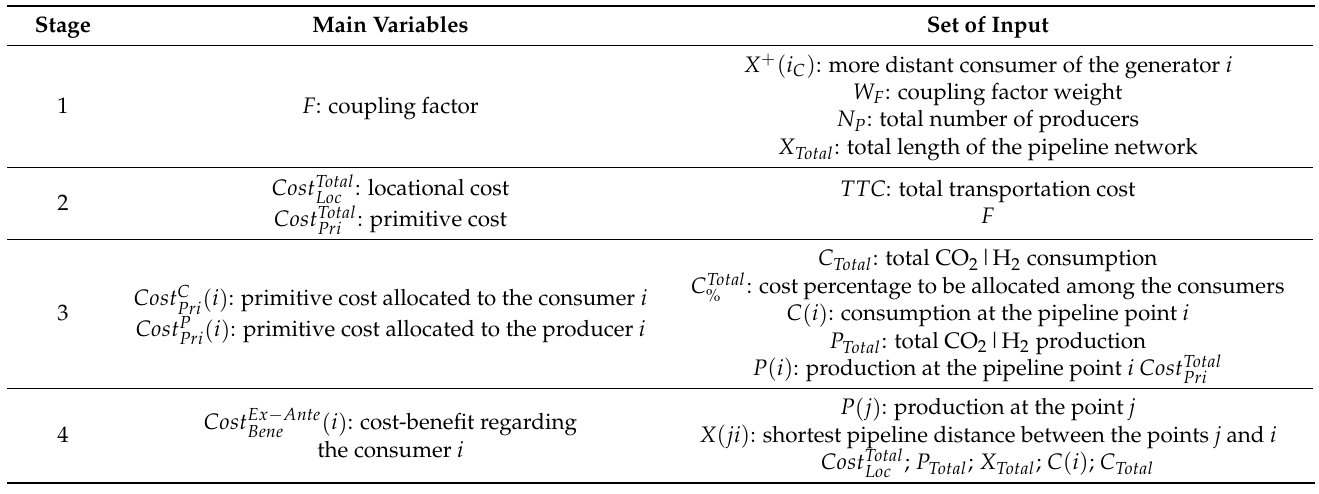
Table 1. Synthesis of the stages that form novel